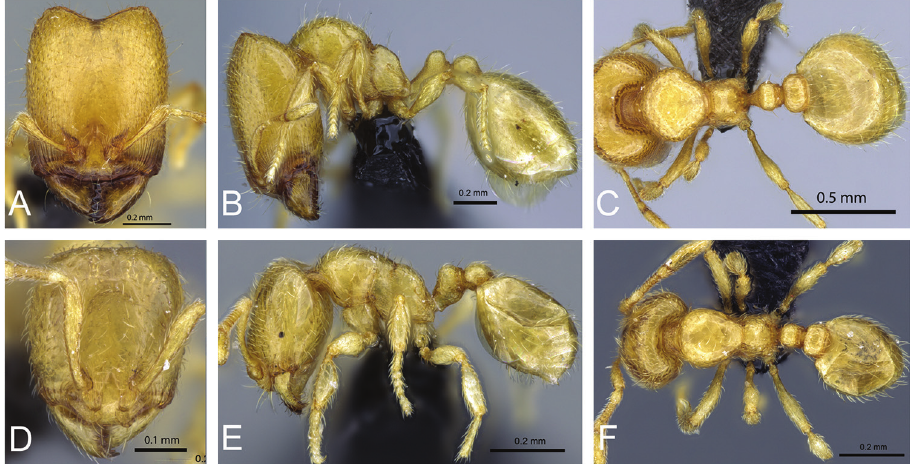
Figure 50. Carebara malagasy –holotype. Major worker, CASENT0044166: A head in full-face view B body in profile view C body in dorsal view. Minor worker, CASENT0044172: D head in full-face view E body in profile view F body in dorsal